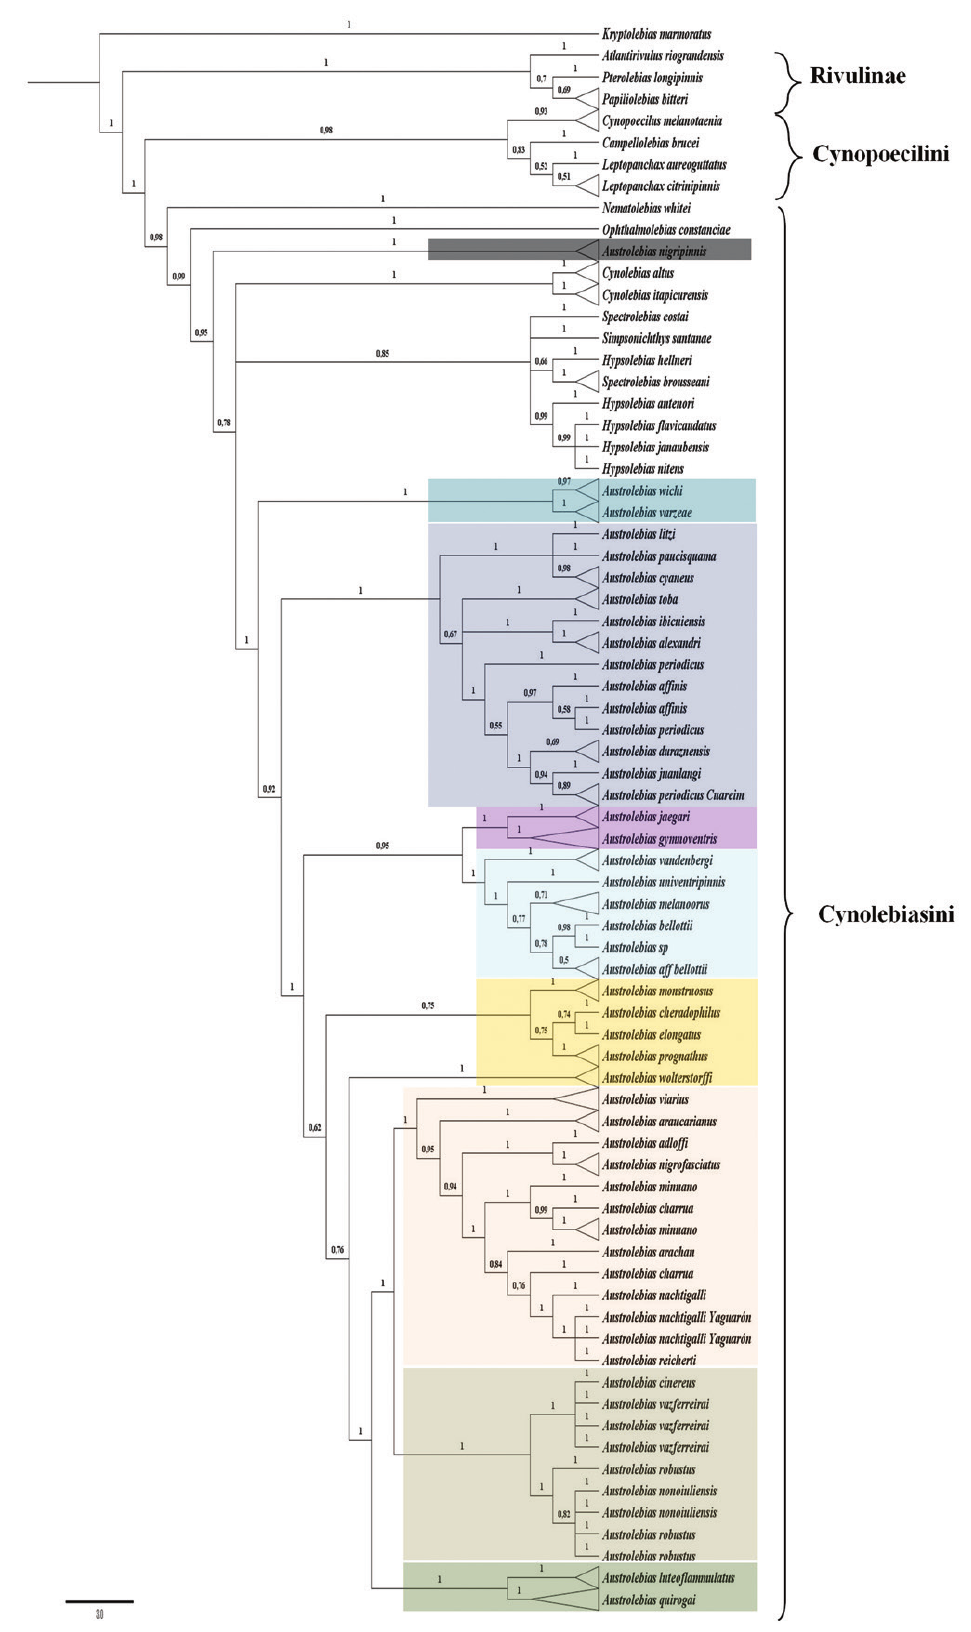
Fig. 10. Bayesian phylogenetic tree of Austrolebias , based on the molecular markers (ribosomal unit 16s, Cytochrome b, RAG1, Glyt). Values above branches are posterior probabilities. Colored areas same as Fig.